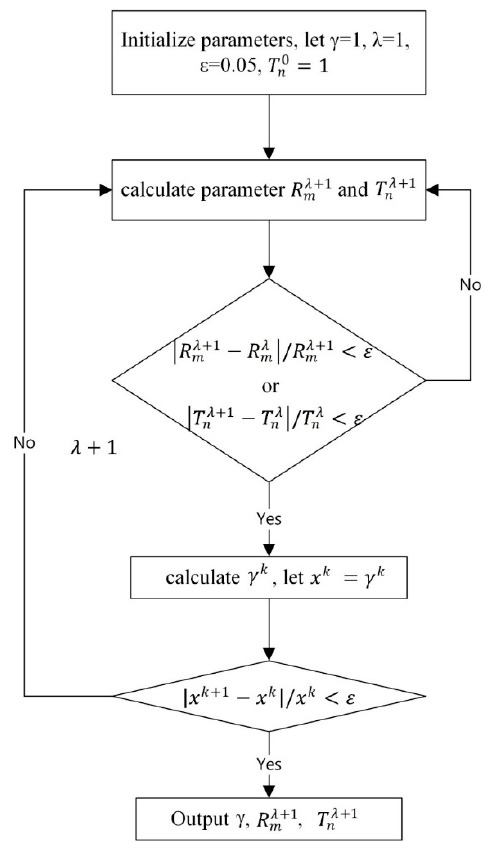
Figure 4. Model solving steps.